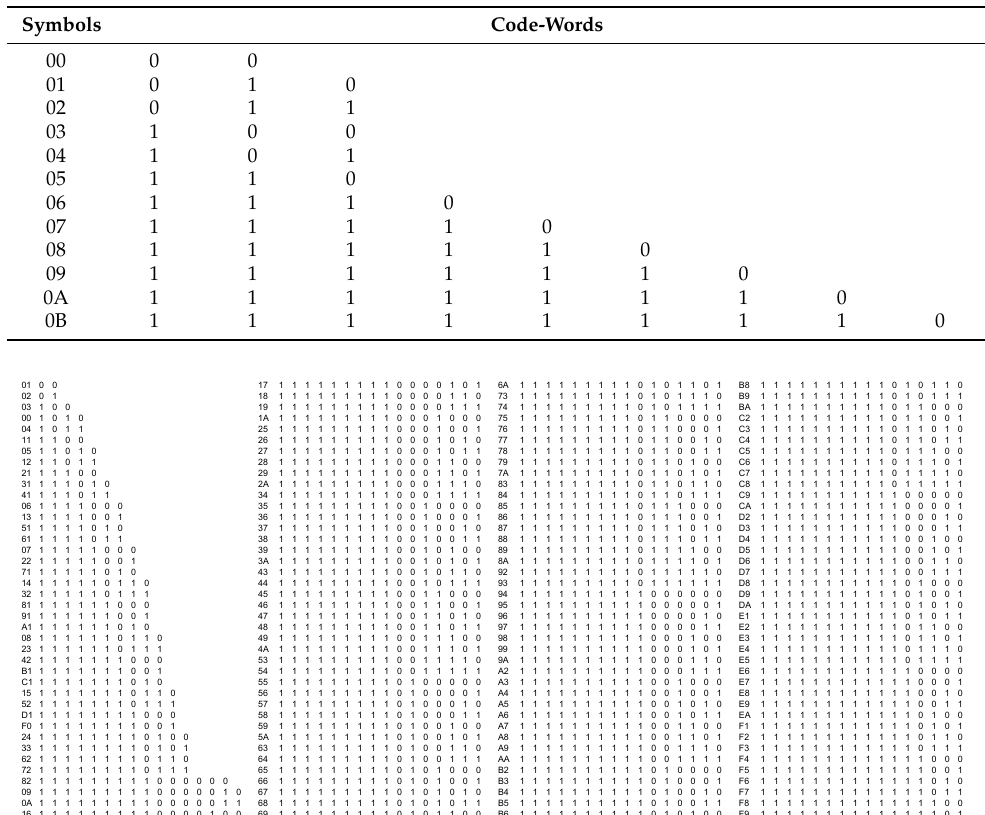
Table A1. DC Huffman table. Less frequent symbols are assigned longer code-words.